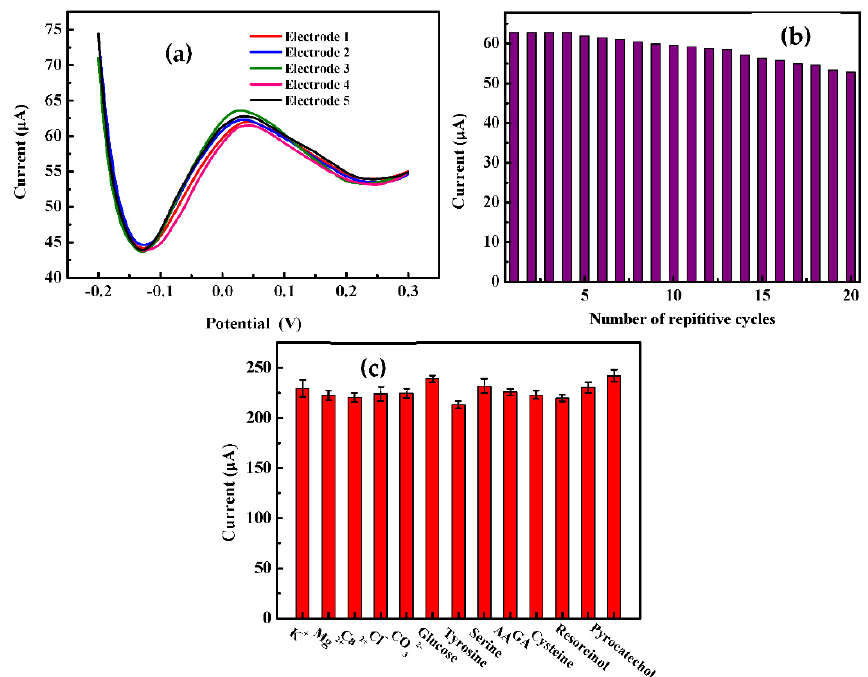
Figure 9. ( a ) CVs of five electrodes prepared independently for measuring 1.0 μ M 4-AP; ( b ) 20 cycles of SWV were carried using 1 μ M 4-AP solution in PBS pH 6.5 at LIC/MWCNT-PANI and ( c ) Anodic current for 4-AP oxidation measured in the presence of 100-fold excess of interfering ions at a